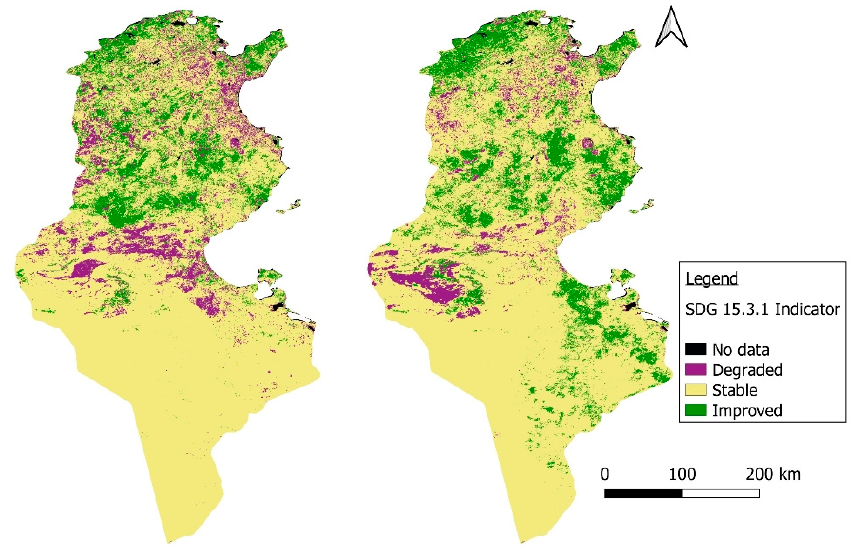
Figure 3. Spatial distribution of SDG 15.3.1 indicator in Tunisia during the baseline period ( left ) and the reporting period ( right ).